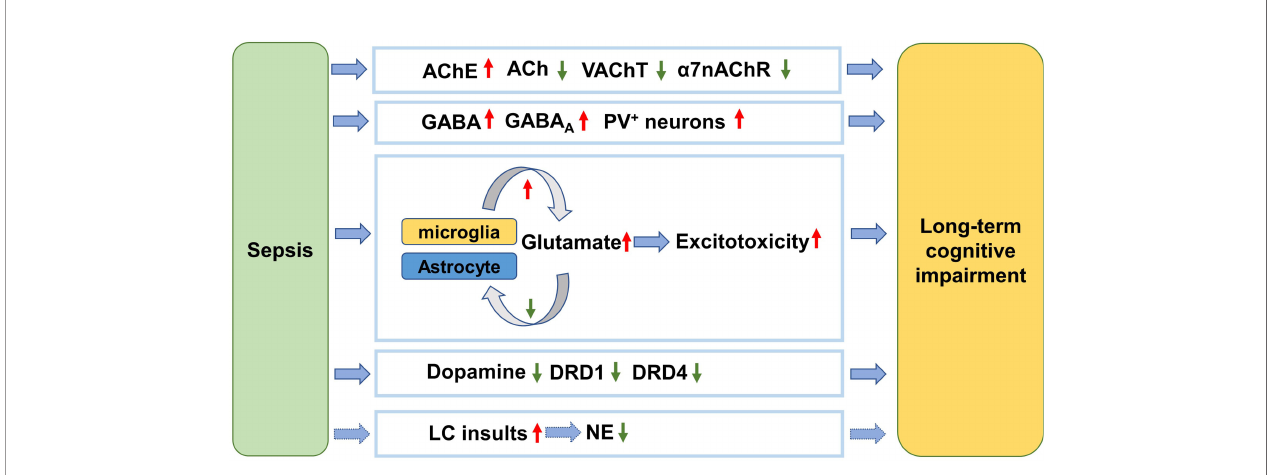
FIGURE 1 | Neurotransmitter dysfunction mechanism underlying long-term cognitive impairment after sepsis. After sepsis, the AChE is activated and the ACh level is thus decreased. Meanwhile the cholinergic innervation is inhibited, as re fl ected by reduction of VAChT. The a 7nAChRs are also downregulated. The suppression of ACh function is associated with cognitive impairment following sepsis. PV + interneurons are activated after sepsis resulting in cognitive impairment. The activated microglia secret more glutamate while the damaged astrocytes reuptake less glutamate, causing excitotoxicity to the brain and cognitive impairment. The level of dopamine is decreased and the receptors are inhibited by sepsis, which is involved in cognitive impairment. The LC is the only source of NE in the brain. NE level decreases in response to sepsis, which contributes to cognitive impairment. AChE, acetylcholinesterase; ACh, acetylcholine; VAChT, vesicular acetylcholine transporter; a 7nAChR, a 7-nicotinic acetylcholine receptor; GABA, Gamma-aminobutyric acid; GABA A , GABA A receptor; PV, parvalbumin; DRD1, dopamine receptor D1; DRD4, dopamine receptor D4; LC, locus coeruleus; NE,